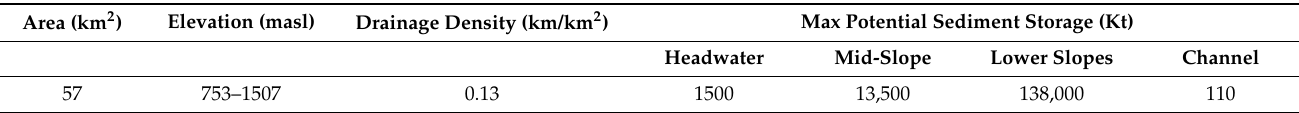
Table 1. Characteristics of the Cranemere